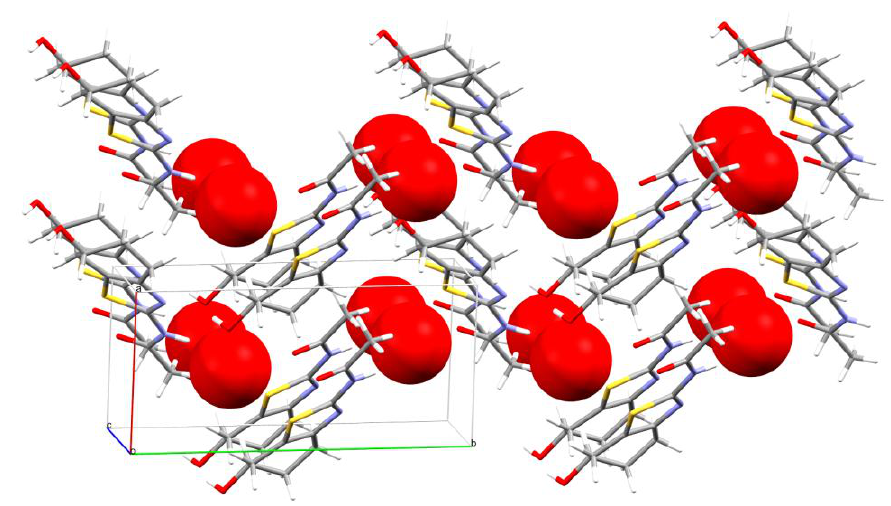
Figure 6. The dashed lines show the intermolecular contacts of ( R )- 4 (left) and of ( S )- 4 (right), viewed along the a axis.